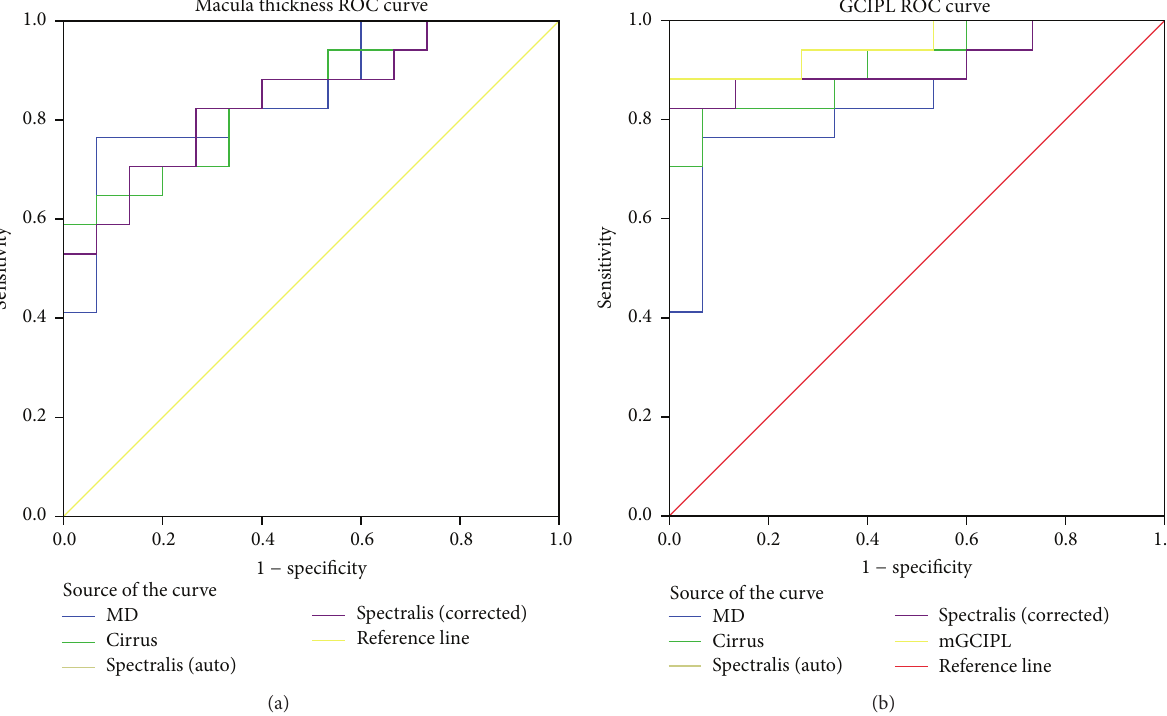
Figure 3: Age-adjusted ROC curves from Cirrus and Spectralis: (a) total macula thickness, (b) GCIPL. Auto: values using automatic segmentation in Spectralis; corrected: values after manual correction of retinal layer segmentation in Spectralis; mGCIPL: minimum GCIPL value calculated by Cirrus software; MD: mean defect.